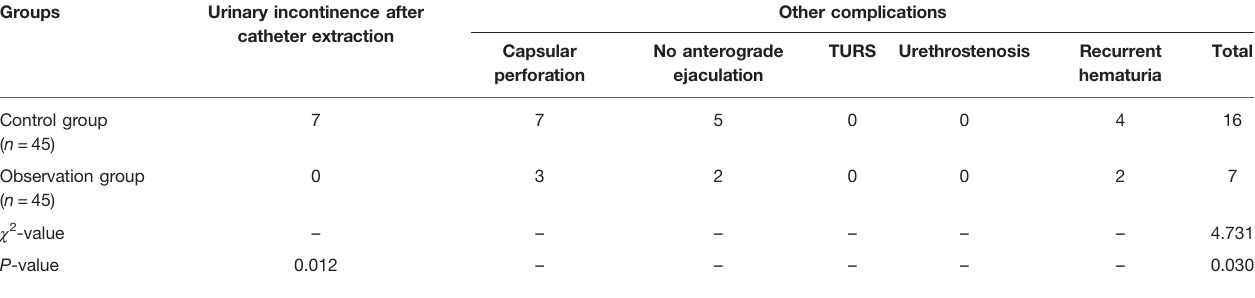
TABLE 4 | Surgical complications in the two groups.